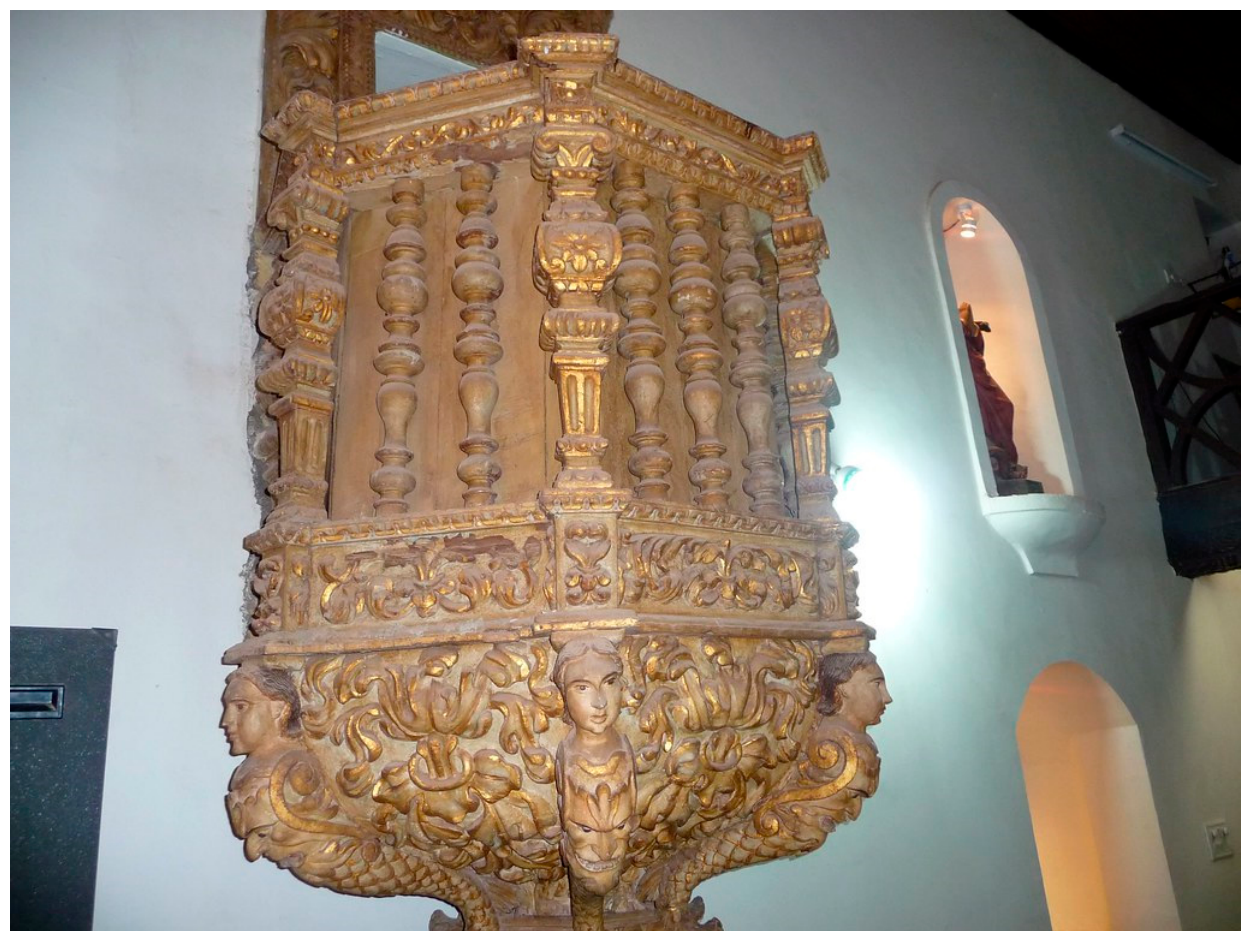
Figure 10. Pulpit in Igreja de Nossa Senhora (Church of Our Lady), 17th century, Goa.